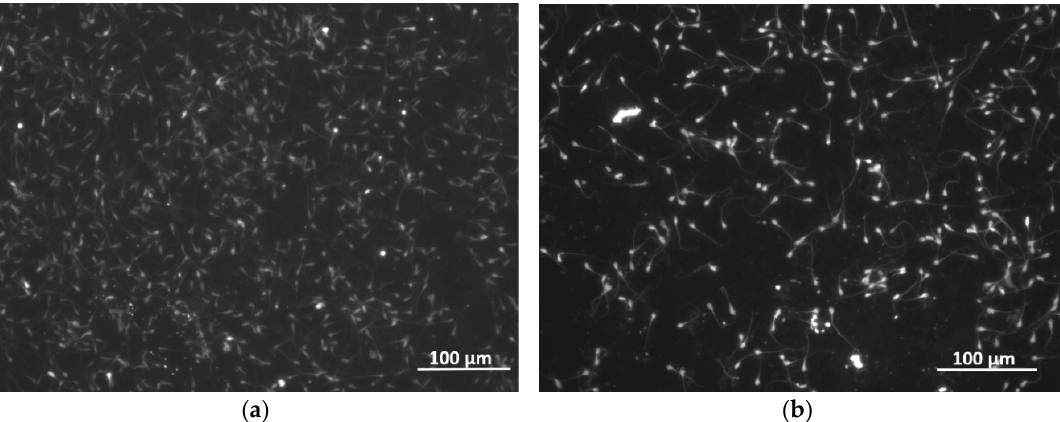
Figure 5. Fluorescence microscopy images of the uncoated sensor surface after the experiments with ( a ) immotile and ( b ) motile human spermatozoa.